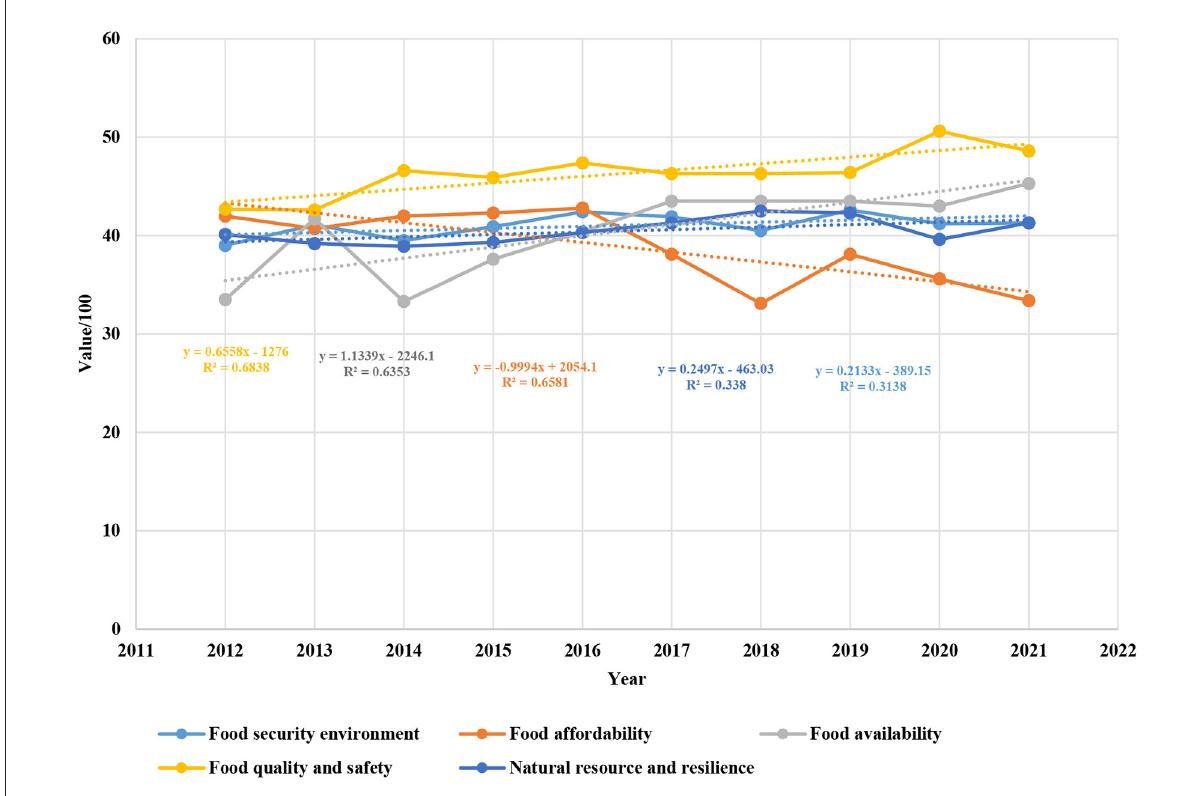
FIGURE11 Food security environment in Nigeria (2012–2021). Source: EIU